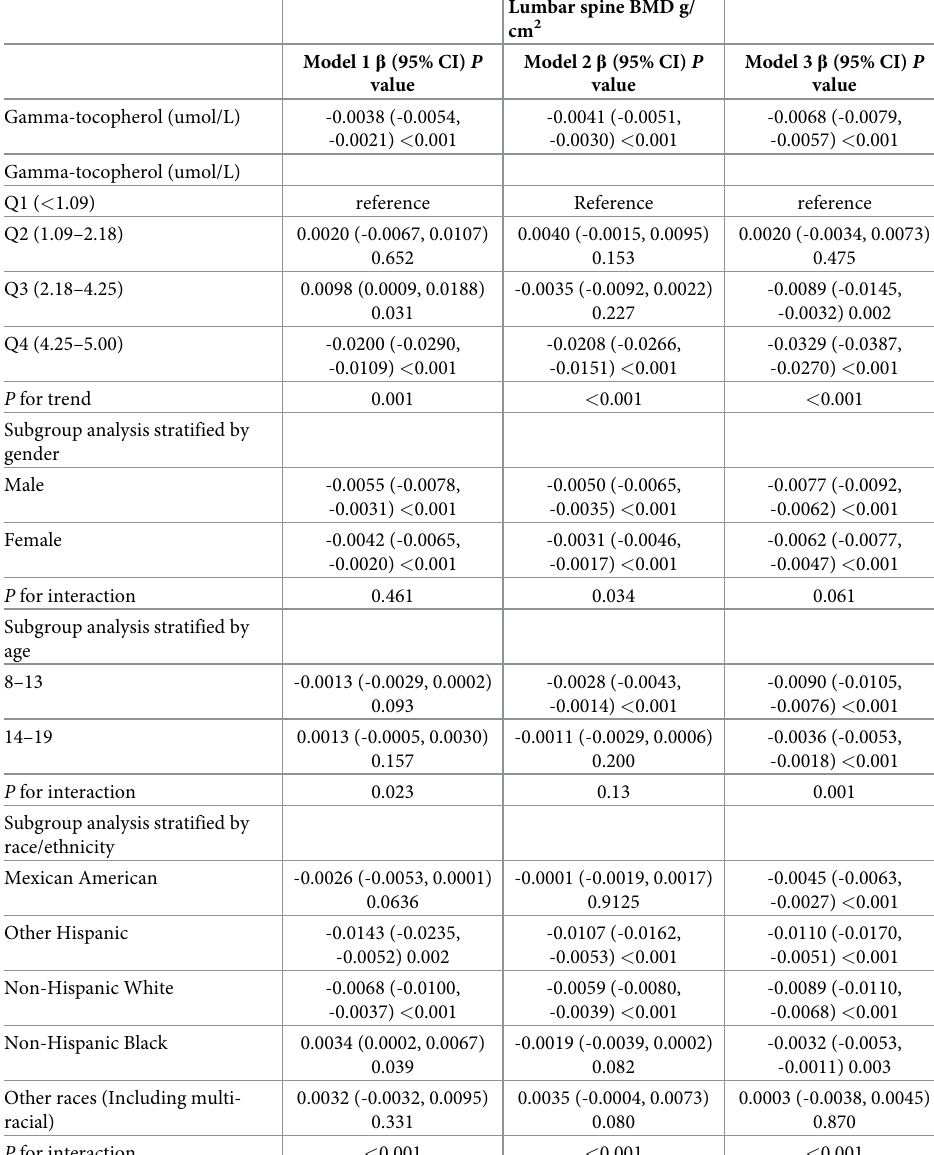
Table 3. The association between serum gamma-tocopherol and lumbar spine